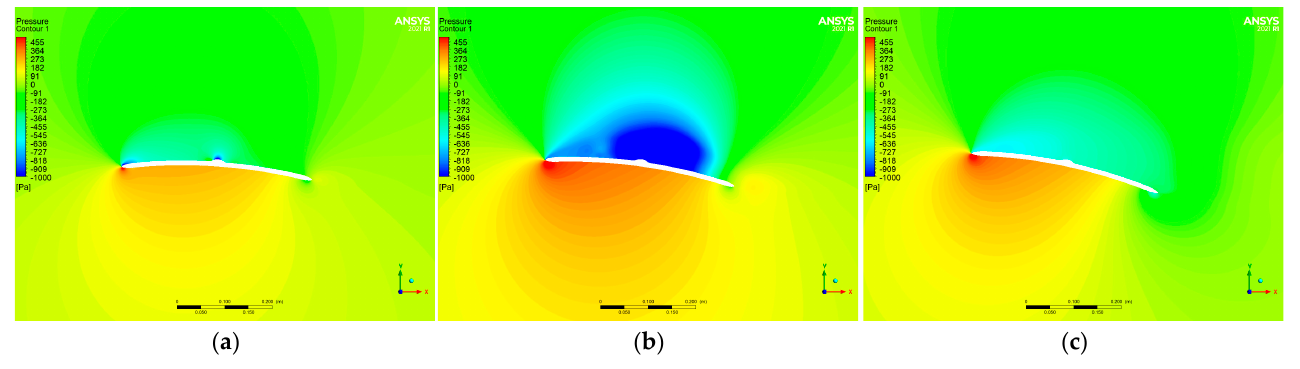
Figure 11. Pressure of proposed airfoil at Re of 60,000. ( a ) Angle of attack of 4°; ( b ) angle of attack of 8°; ( c ) angle of attack of 12°.